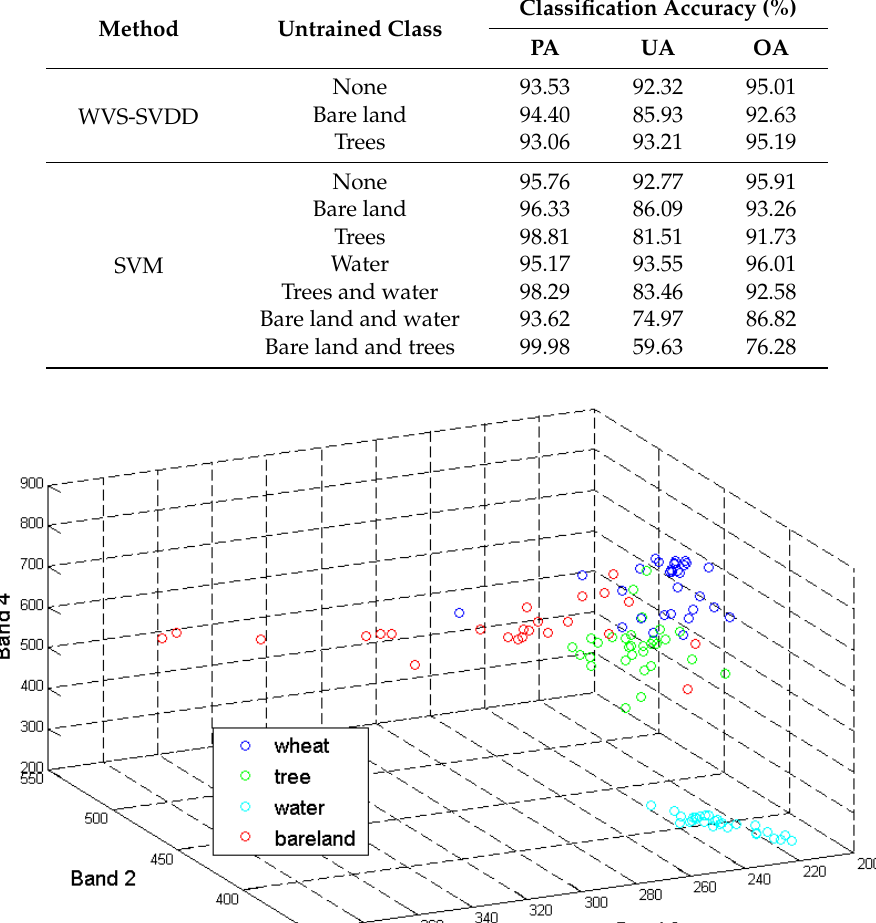
Figure 8. Three-dimensional scatterplot of land-cover types in the study area.